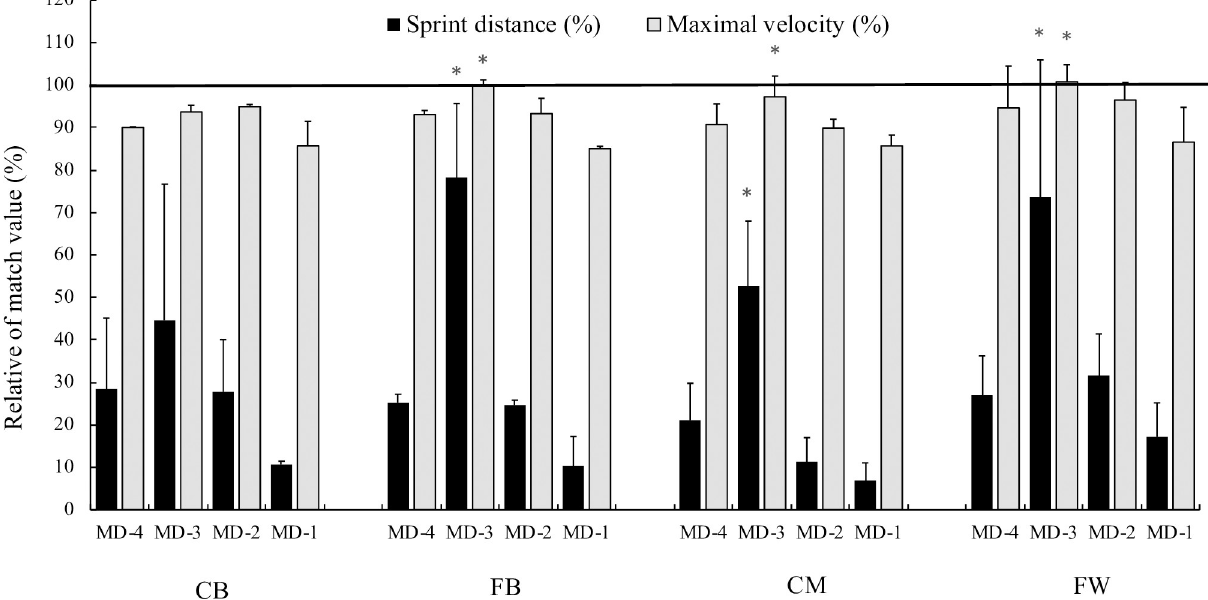
Fig 1. Sprint distance and maximal velocity for professional players relative to match play in training sessions. � = denote differences from MD- 1. CB = central defender; FB = fullbacks; CM = central midfielder; FW = forwards.